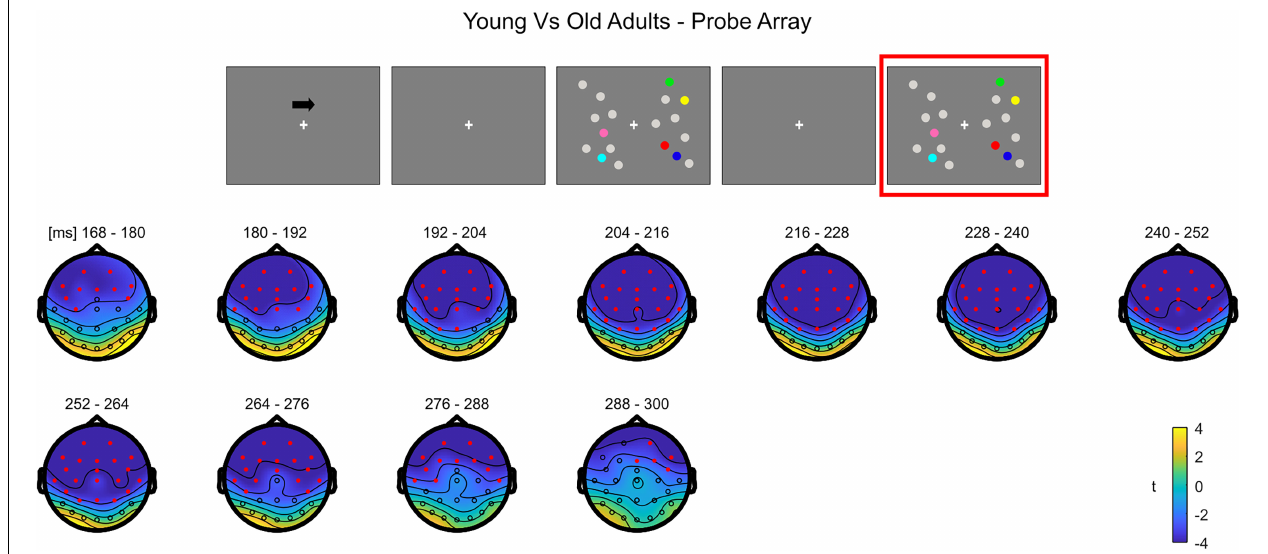
FIGURE 9 | Cluster-based permutation independent-samples t -test results on the load effect between the two groups during item comparison. The spatio-temporal evolution of the significant Group effect is represented through topographical maps of the clusters averaged in bins of 12 ms. Only significant time windows are depicted (for the complete time course, see Supplementary Figure 6 ). Red dots represent the significant effect. The color bar represents the range of t -values. Left and right channels are set as contralateral and ipsilateral to targets,